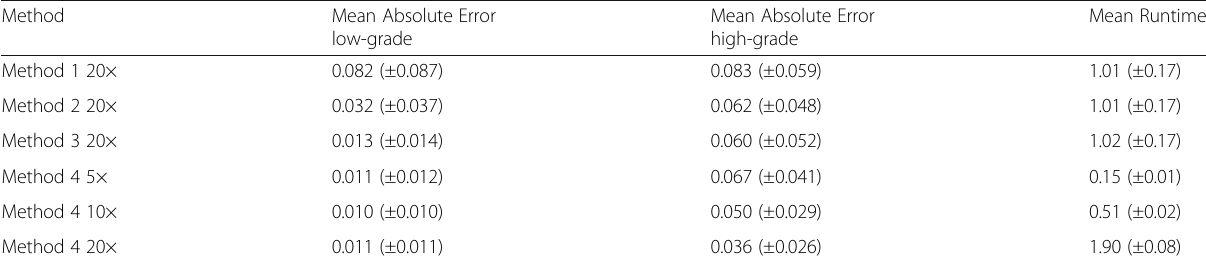
Table 2 Method evaluation results Method